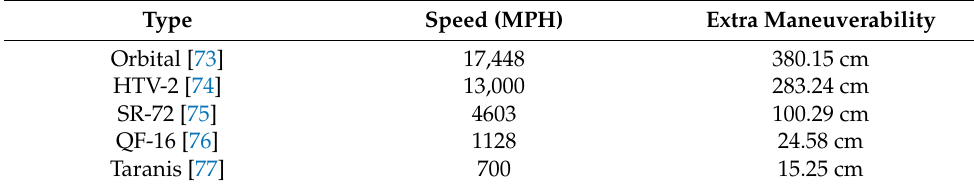
Table 7. Extra maneuverability caused by hardware implementation for different craft speeds for Network 1.